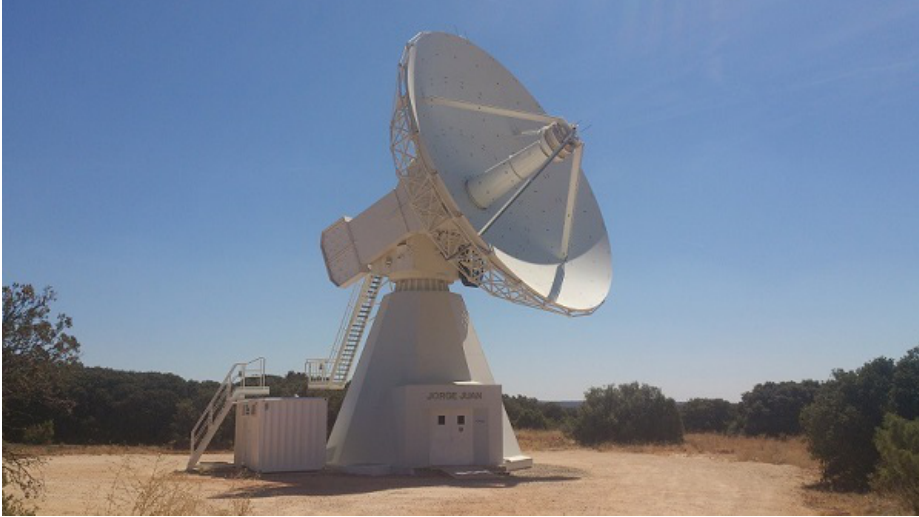
Figure 1. Yebes RAEGE VGOS 13.2 m radio